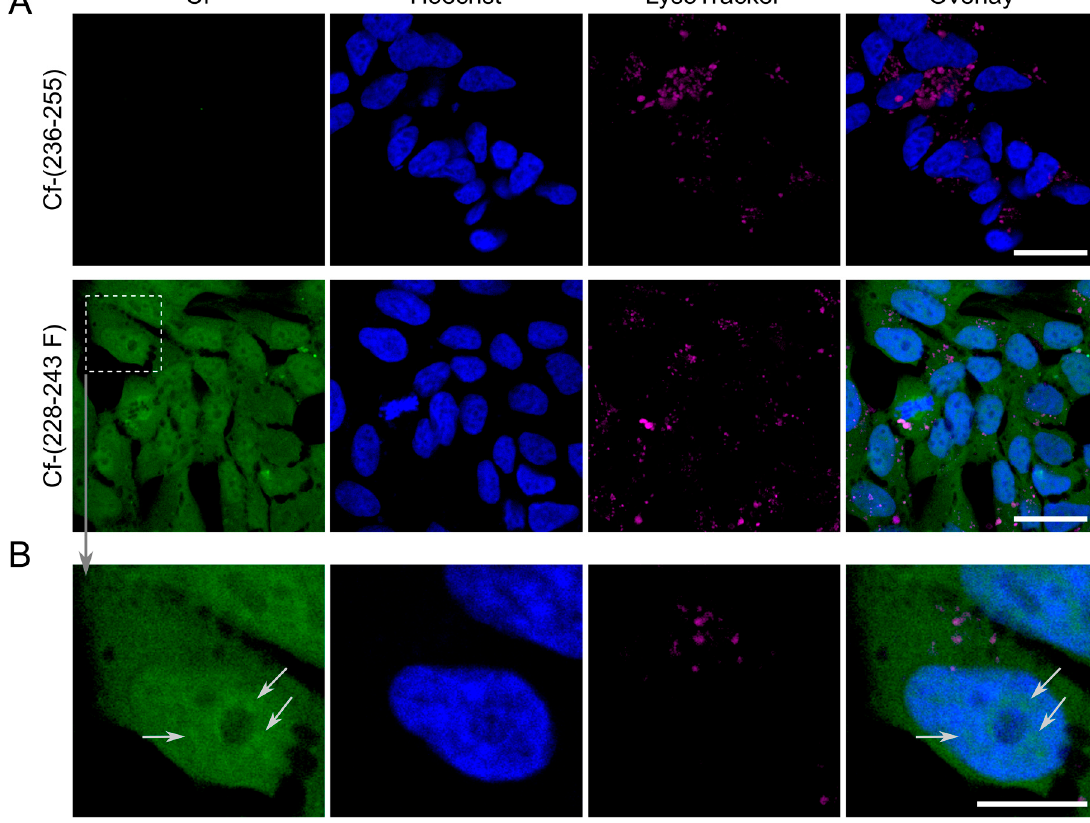
Figure 7. ( a ) Intracellular localisation of peptides Cf-(228–243 F) and Cf-(236–255) by confocal laser scanning microscopy. Cells were incubated for 3 h with Cf-labelled peptides (c = 25 μ M, green), lysosomes were labelled with LysoTracker Deep Red (magenta), nuclei were stained by Hoechst 33342 (blue). ( b ) Enlargements present ubiquitous distribution of peptide Cf-(228–243 F). Scale bar represents 20 μ m (a) and 10 μ m (b).